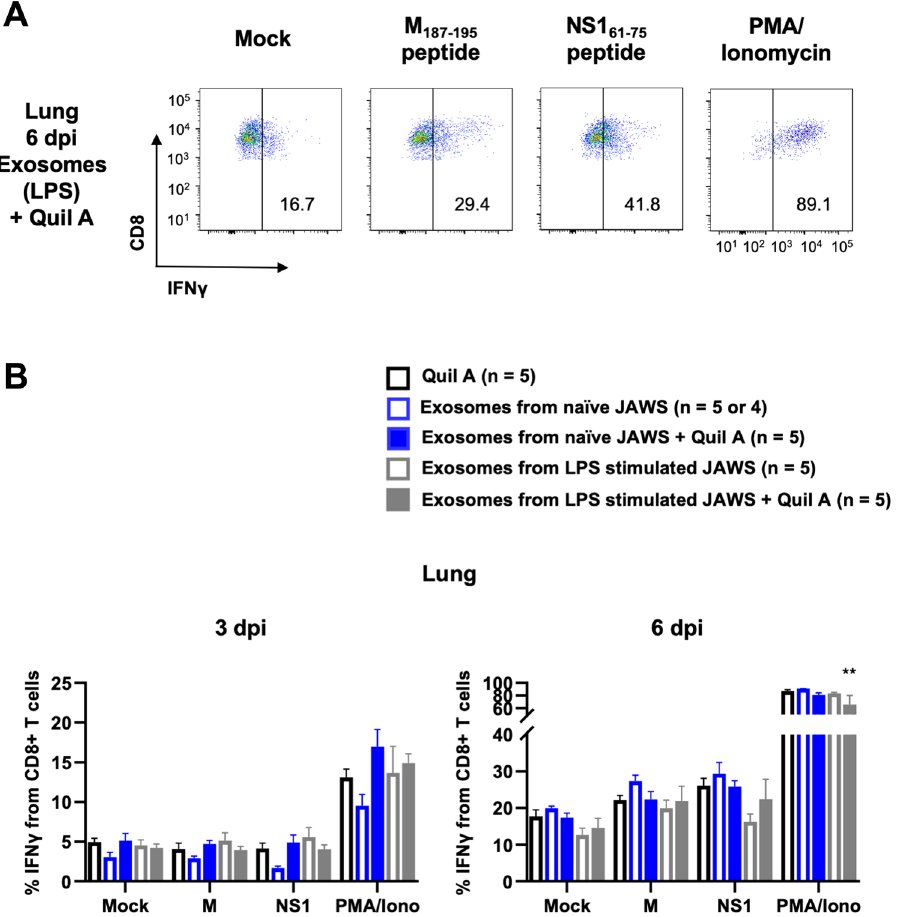
Figure 4. The production of IFN-γ by M 187–195 or NS1 61–75 -specific T cells in the lungs. Groups of vaccinated mice were sacrificed either 3 or 6 days post-infection (dpi). Their lungs were stained with antibodies and analyzed by flow cytometry. ( A ) Representative flow cytometry plots showing IFN-γ producing lungs from a group of exosomes from LPS stimulated JAWS with Quil A at 6 dpi of RSV after stimulation with M 187–195 or NS1 61–75 peptides. ( B ) Flow cytometric analysis of IFN-γ production by lungs in the CD45+ CD8+ T cell population after stimulation with the indicated conditions. Data are presented as means ± SEM. **p < 0.01 as determined by two-way ANOVA and Tukey’s multiple comparisons